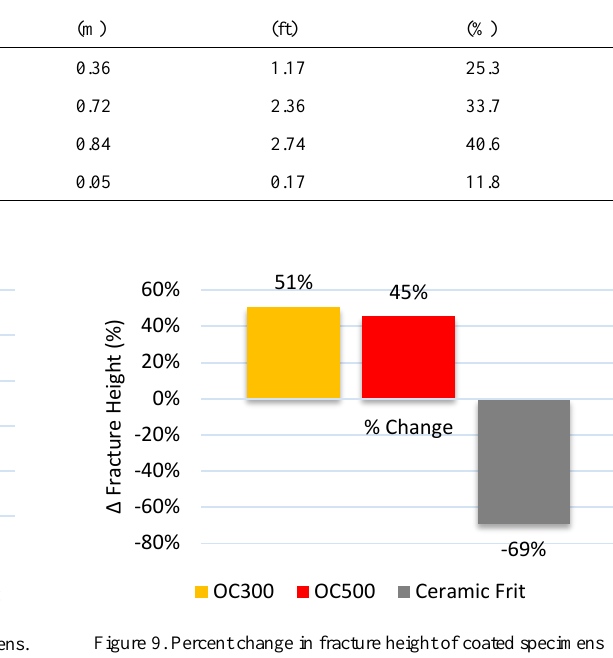
relative to uncoated glass